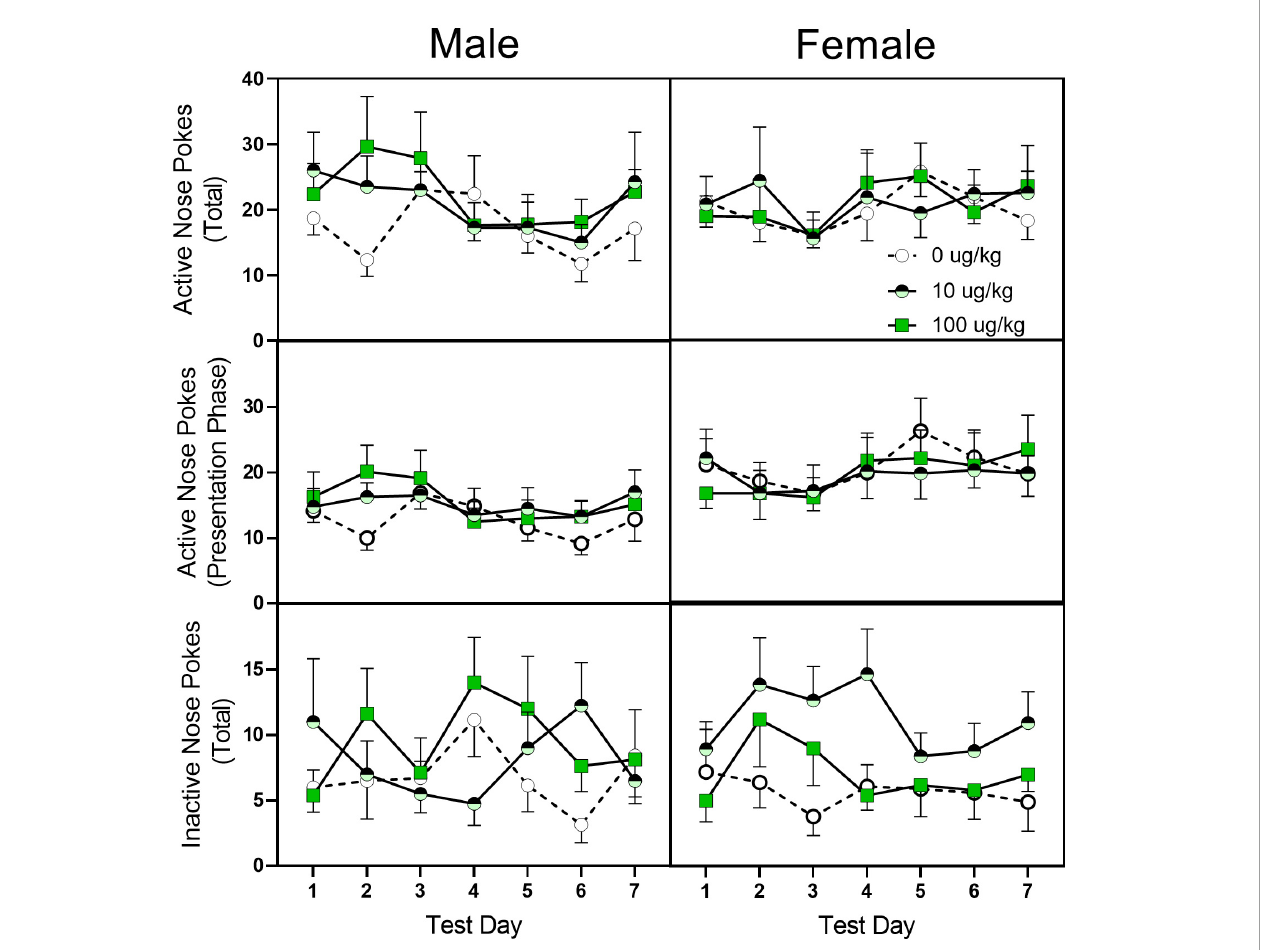
FIGURE6 Mean ( ± SEM) active nose pokes, active nose pokes during the stimulus presentation, and inactive nose pokes in late adolescent male and female rats ( n = 6–8/sex) during the seven fentanyl-only acquisition test days. Rats were pre-treated with fentanyl (10 or 100 µ g/kg) or saline from PD 4 to PD 9 and started sucrose training on PD 40. After reaching the criterion for sucrose-rewarded nose pokes, rats underwent a four-phase sucrose fade out/fentanyl fade in procedure and then were assessed for 7 days for fentanyl-only